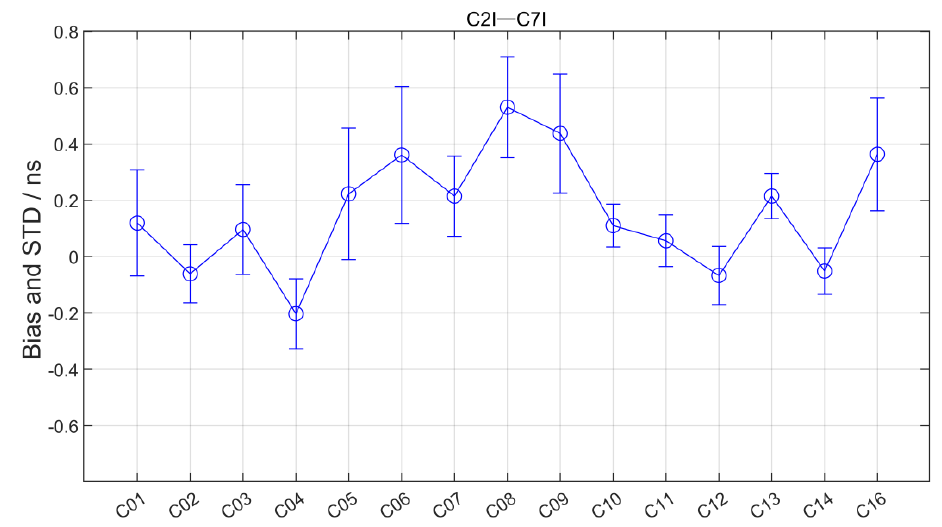
Figure 26. Comparison results between DCB and CAS products of BDS satellite.